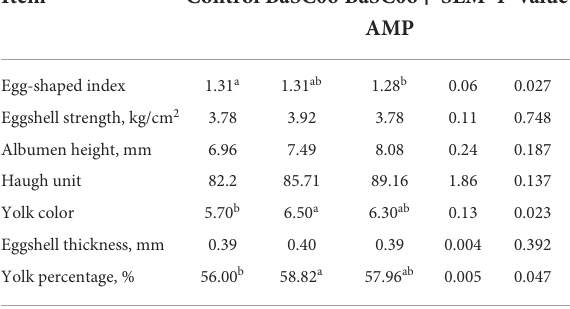
TABLE 3 Laying performance of laying hens fed different biological feed additives 1 .